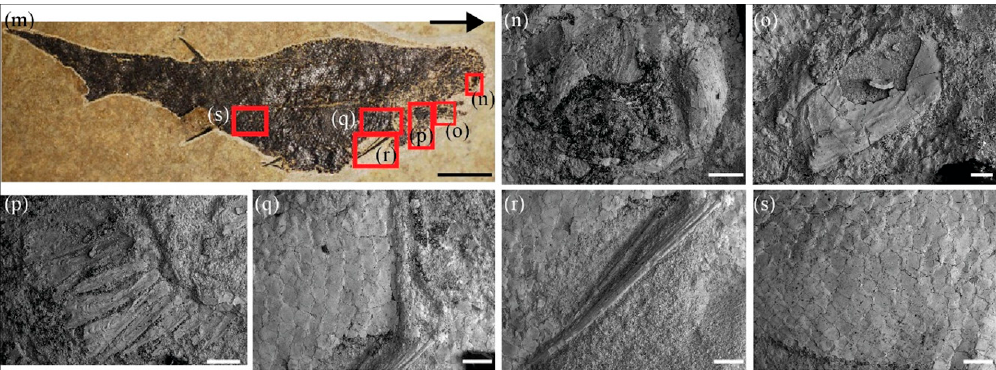
Figure 2. Triazeugacanthus affinis anatomical structures for EDX analyses. ( a ) Juvenile specimen MHNM 03-2684 and SEM close-ups of the ( b ) eye lenses, ( c ) otolith, ( d ) scapulocoracoid, ( e ) pectoral spines, and ( f ) scales. ( g ) Adult specimen MHNM 03-2669 and SEM close-ups of the ( h ) eye lenses and sclerotic plates, ( i ) branchiostegal rays, ( j ) scapulocoracoid, ( k ) pectoral fin spine and ( l ) scales. ( m ) Adult specimen MHNM 03-1497 and SEM close-ups of the ( n ) sclerotic plates, ( o ) palatoquadrate process, ( p ) branchiostegal rays, ( q ) scapulocoracoid, ( r ) pectoral fin spine and ( s ) scales. Red squares show SEM close-up areas. Arrows point forward. Scale bars = 5 mm in (a), (g) and (m); 200 μ m in (b) and (h), 10 μ m in (c), 100 μ m in (d), (i), (o); 500 μ m in (e), (j), (k), (n), (p), (q), (r), (s); 50 μ m in (f).